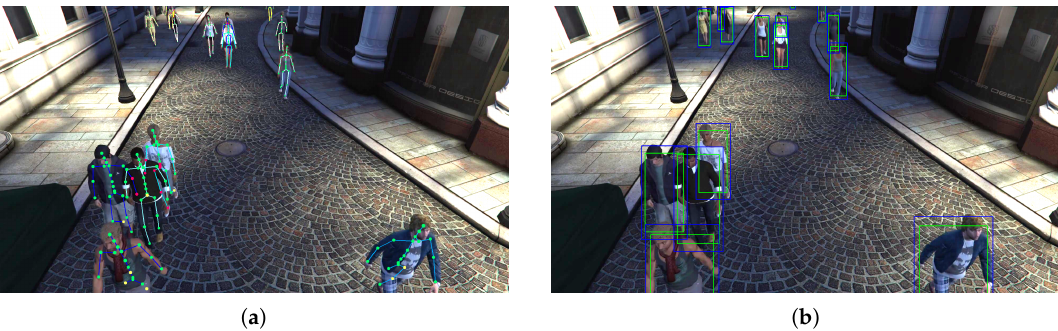
Figure 1. ( a ) Pedestrians in the JTA (Joint Track Auto) dataset with their skeletons. ( b ) Examples of annotations in the ViPeD (Virtual Pedestrian Dataset) dataset; original bounding boxes are in green, while the sanitized ones are in